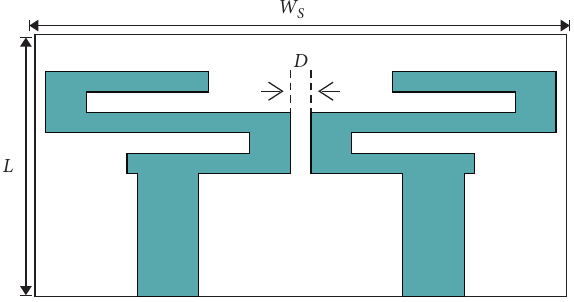
Figure 4: Design of the proposed MIMO antenna.